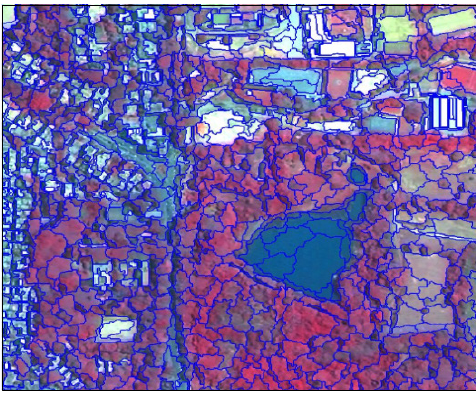
Figure 4: Segmentation (Level